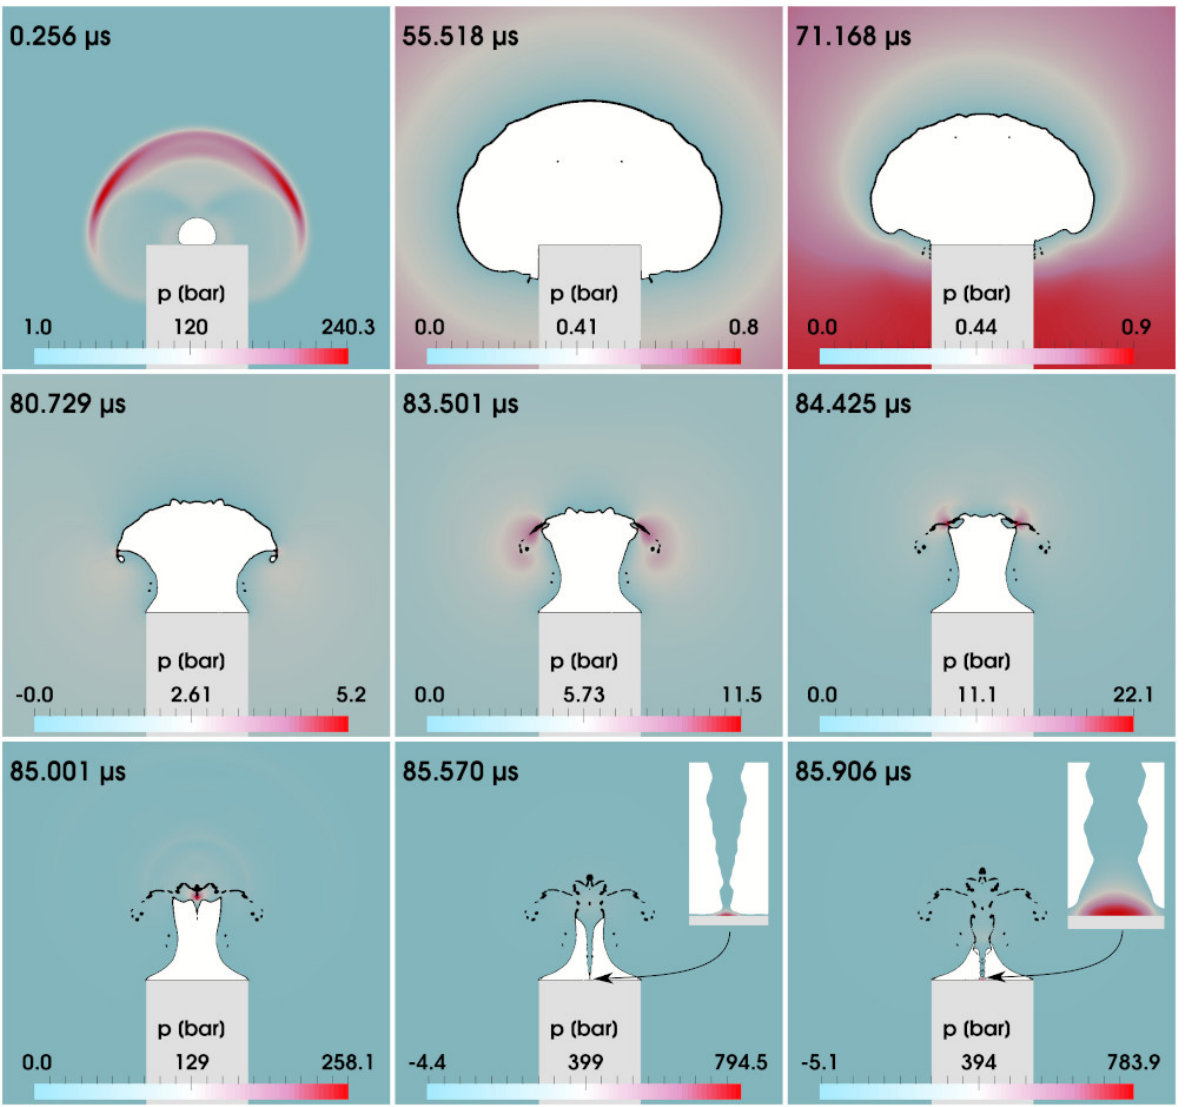
Figure 10. Simulation results for the pressure p [bar] of a bubble with R max,unbound = 472.57µm, D init = 30µm and a cylinder radius of r p = 200µm, resulting into D ∗ = 0.06 and r ∗ p = 0.423. White areas belong to the bubble. Cross sections along the center of axial symmetry. In the first frame (upper left frame), the shock wave from the bubble initiation is visible as is the low-pressure wave from diffraction at the rim of the cylinder. The last two frames contain a zoom inset into the region of maximum pressure at the flat top surface of the cylinder. Rayleigh collapse time T Rc is